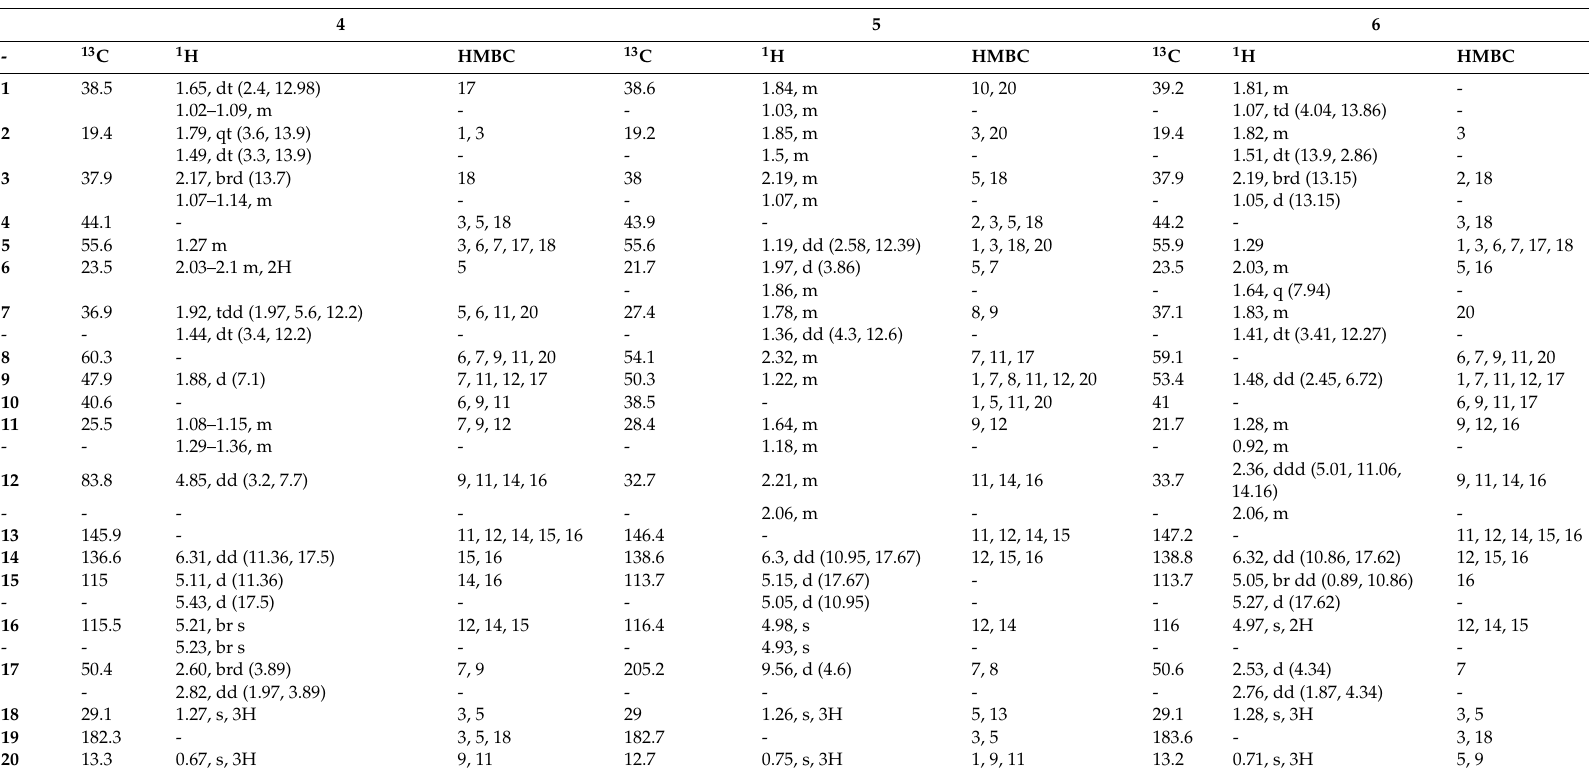
Table 3. 13 C and 1 H NMR data for new compounds. 12-hydroxy-8 R ,17-epoxy-isocommunic acid ( 4 ), 8 S -formyl-isocommunic acid ( 5 ), and 8 R ,17-epoxy-isocommunic acid ( 6 ). HMBC, heteronuclear multiple bond